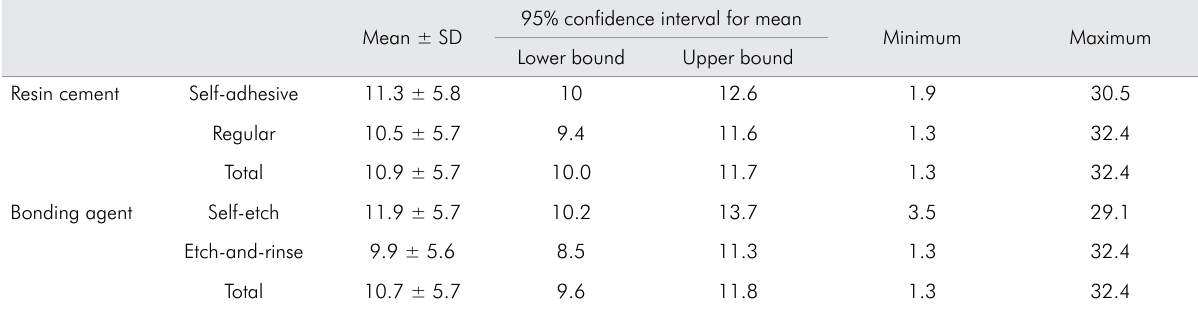
Table 1. Bond strength values (MPa) from the included